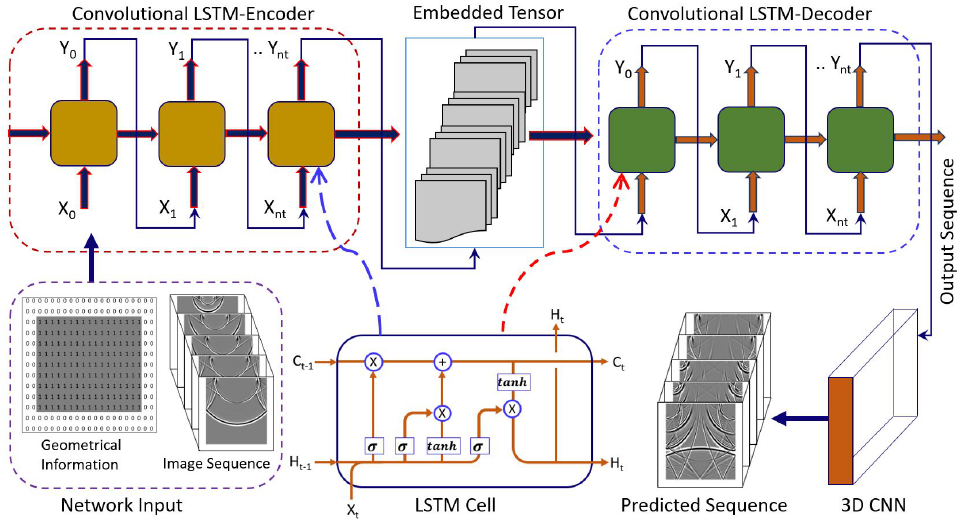
Figure 2. Typical spatio-temporal deep learning (SDL) model encoder–decoder architecture, for modelling wave propagation